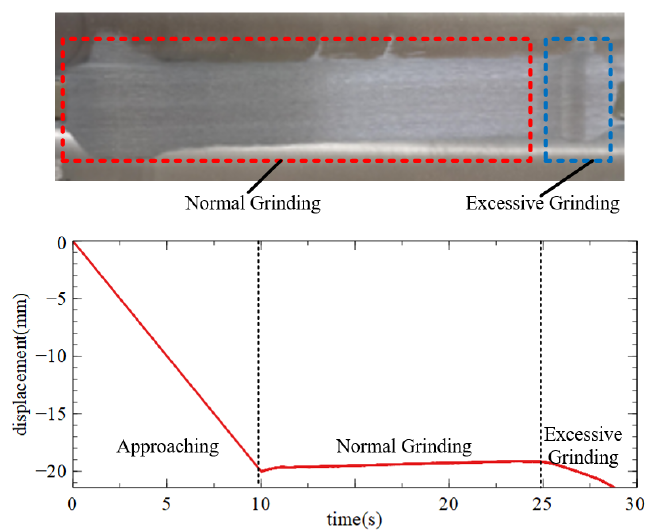
Figure 13. Result of uniform line weld seams